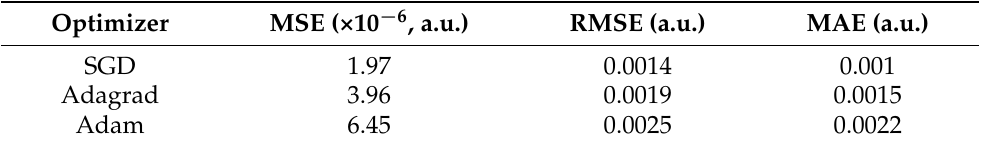
Table 5. Average of each model on evaluation metrics when predicting γ in the test dataset under different combinations of